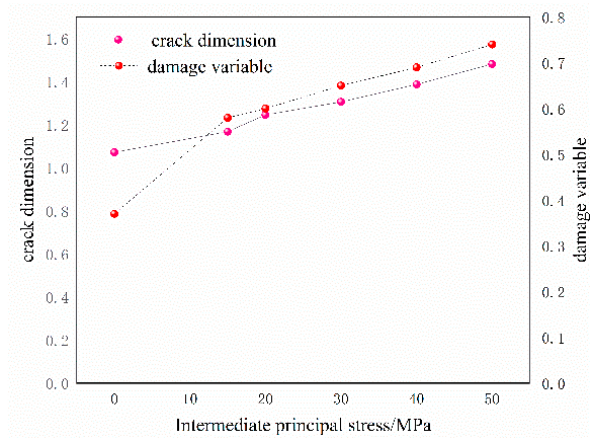
Figure 10. Fracture dimension—damage variable.